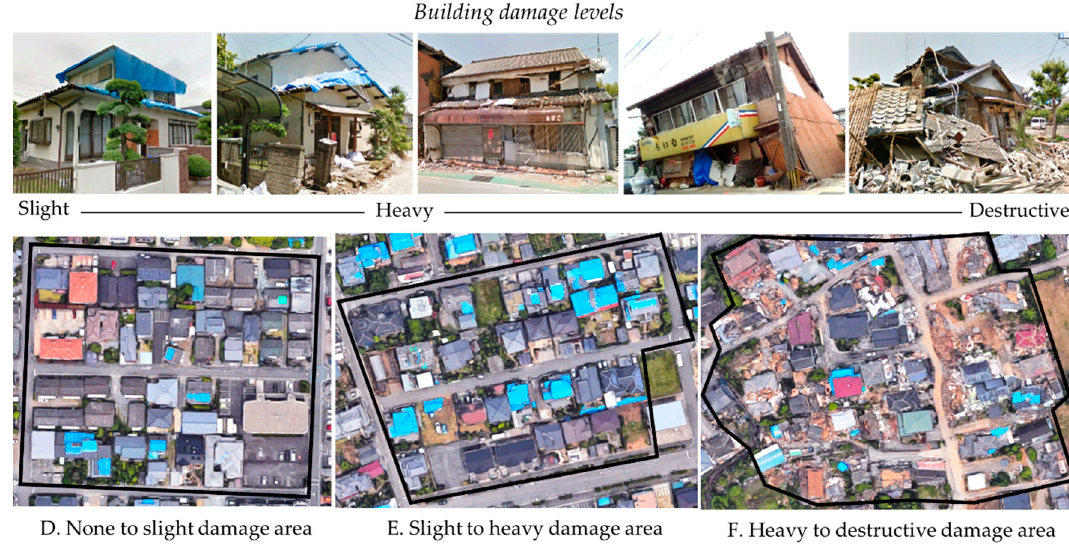
Figure 6. Examples of the urban damage degrees considered as ground truth for the accuracy assessment. Damaged areas were observed from Google Maps (2017). Field surveys and Google Street View after the earthquake also confirmed the damage levels. The locations of ground truth examples are provided in Figure 7.